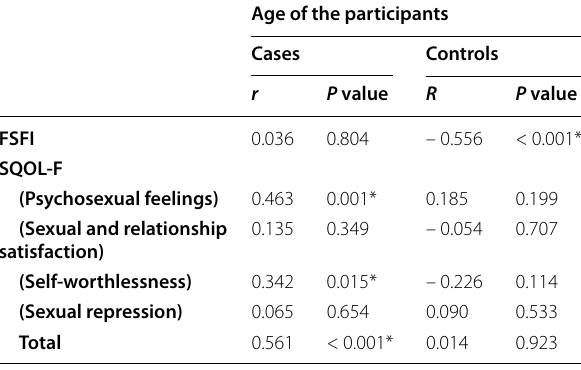
Table 5 The relation between the age variable and both FSFI and SQOL-F scores